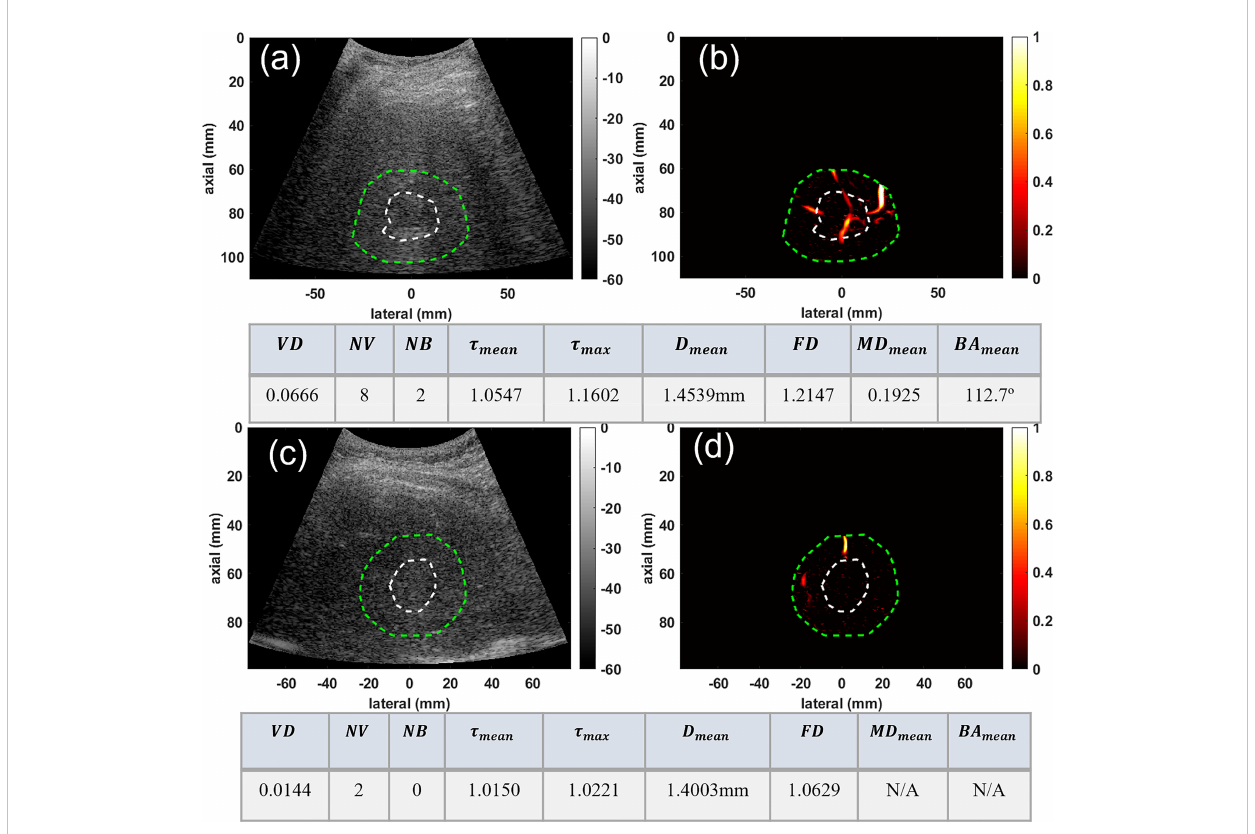
FIGURE 4 Visualization and quanti fi cation of small HCC and benign masses. (A) B-mode image of a 29mm HCC tumor (B) Microvasculature image inside the dilated HCC tumor mask (C) B-mode image of a 22mm benign lesion (D) Microvasculature image inside the dilated benign lesion mask. In all images the white dashed line indicates the boundaries of the lesion, and the green dashed line delineates the boundaries after a 10mm dilation. The tables below each row of images show metric values for the HCC (top) and benign (bottom) lesions.